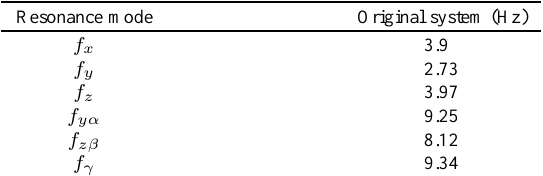
Fig. 4. Vertical force transmission at mount 1-infinite plate with light fluid loading under the unit moment excitation around z-axis at c.g. of rigid body. Table 2 System natural frequencies with rigid